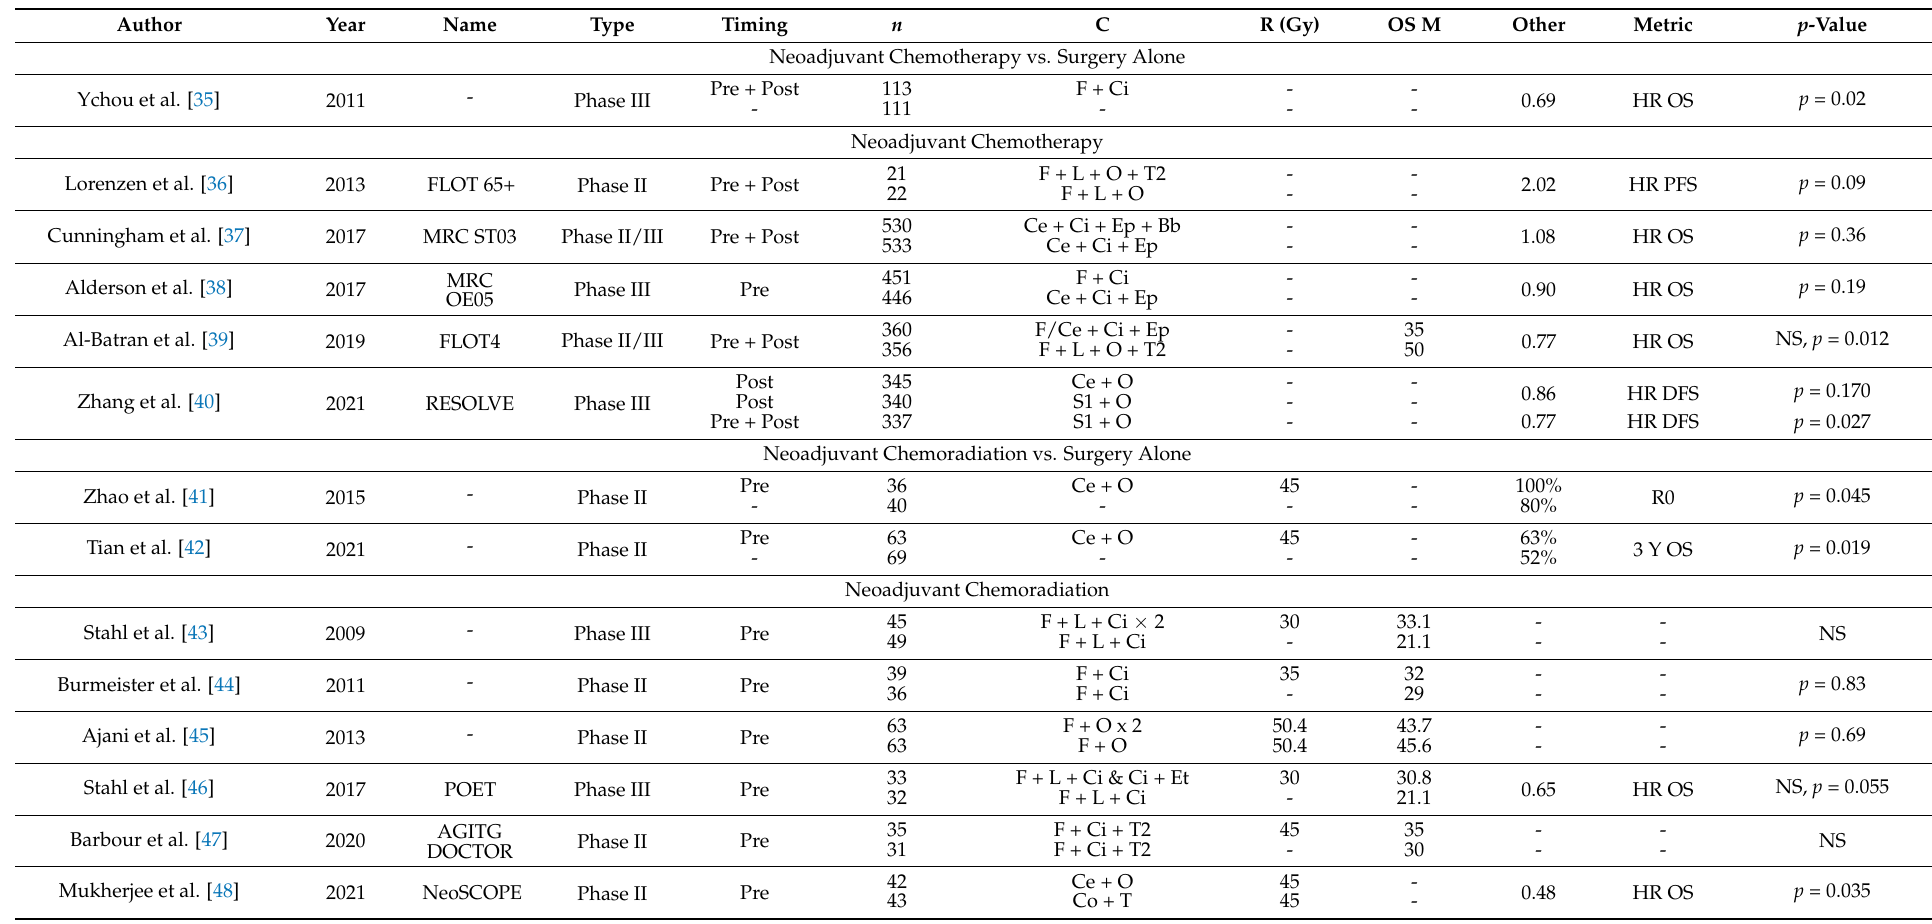
Table 3. Randomized Controlled Trials (RCTs) Evaluating Esophageal and Gastroesophageal Junction (GEJ) Adenocarcinoma